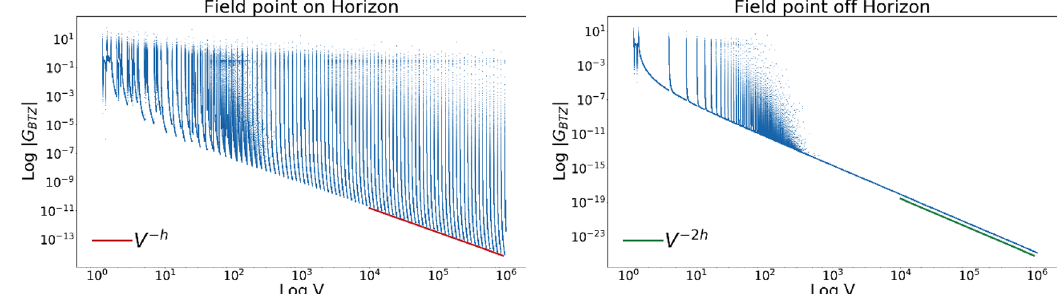
Figure 4 . The BTZ retarded Green function with (cid:12)eld point o(cid:11) the horizon, sampled uniformly in log V . The (cid:12)eld decays at di(cid:11)erent rates depending on whether the (cid:12)eld point is on the horizon (left plot, V (cid:0) h ) or o(cid:11) the horizon (right plot V (cid:0) 2 h ). The slower decay is due to spikes from wavefronts that orbit many times near the black hole and cross the horizon at arbitrarily late times. Spikes also arrive at arbitrarily late times from wavefronts that spend their time mainly far away from the black hole, but they are exponentially narrow and are not visible in the plots at late times (and do not a(cid:11)ect the decay envelope). In these plots we have chosen R H = 0 : 01 and (cid:23) = 1 : 2 such that h = 1 : 7, with (cid:14) (cid:8) 0 = 0 and R 0 = 10; in the left plot we have R = R H = 0 : 01, while in the right plot we have R = 1 > R H